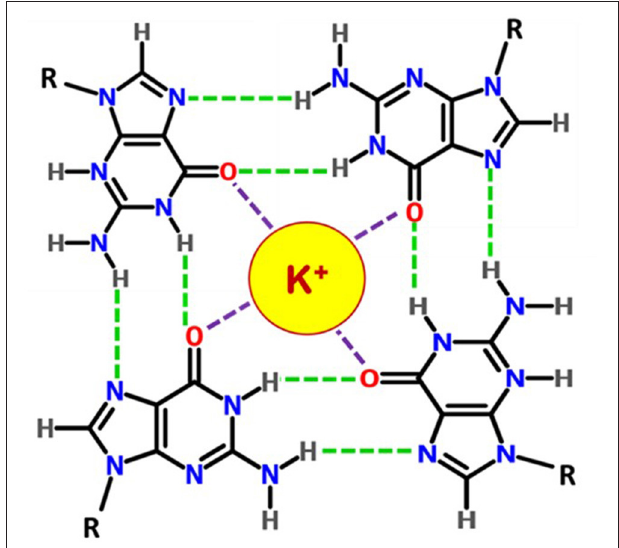
FIGURE 2 | Chemical structure of a G-quartet. Four guanosines are hydrogen bonded (green dashes) by Hoogsteen base pairings and the monovalent cation K + interacts with O6 atoms (in red).